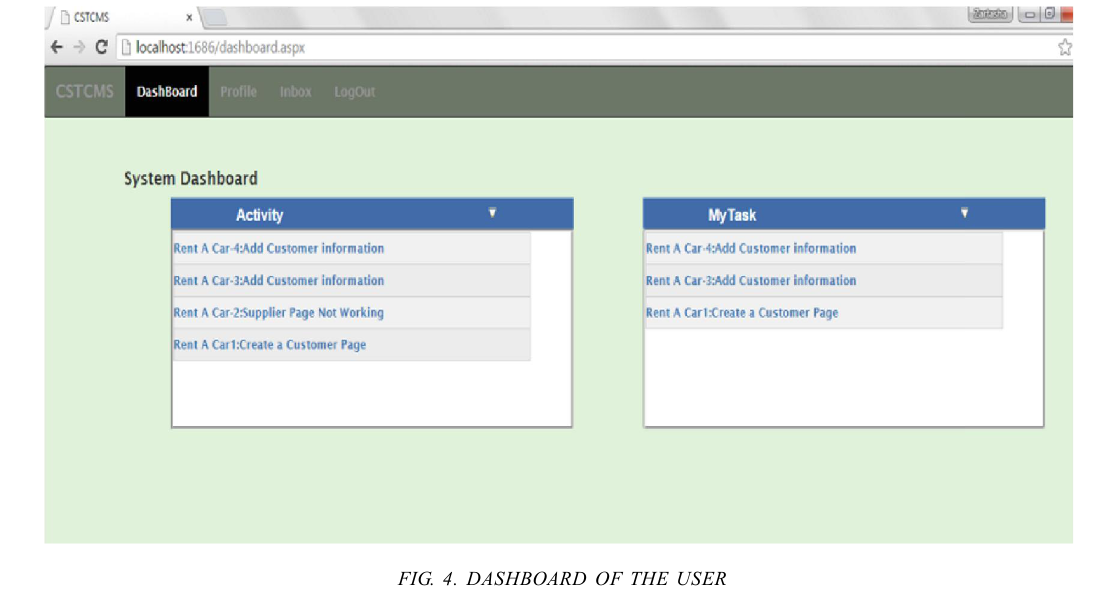
FIG. 4. DASHBOARD OF THE